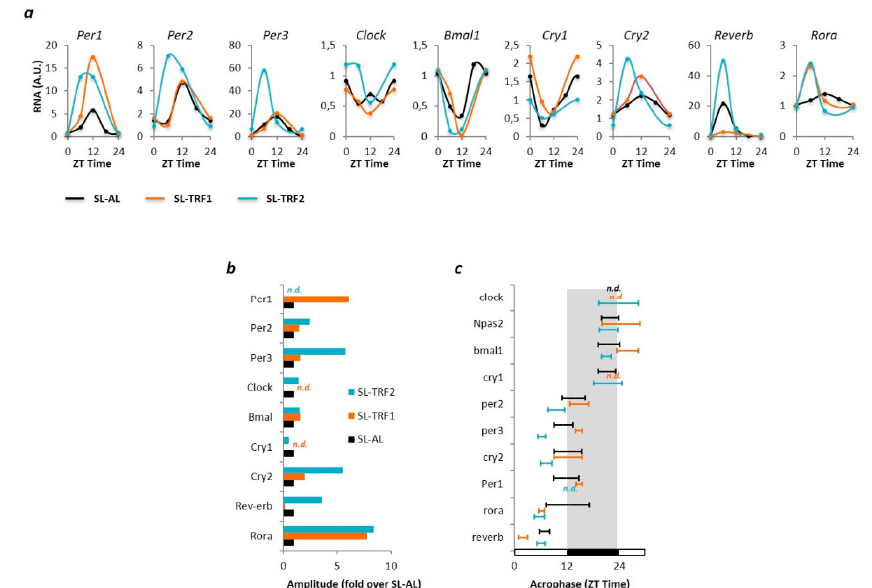
Figure 4. The chrono-nutritional interventions influence the expression of the hepatic clock genes in SL mice. ( a ) mRNA expression levels of the clock genes at different Zeitgeber Time (ZT) during a 24-h cycle in SL-AL mice (black) ( n ≥ 10), SL-TRF1 mice (orange) ( n ≥ 5) and SL-TRF2 (blue) ( n ≥ 5) after 4 weeks of intervention. Gene expression levels were normalized to b-Actin . Amplitude ( b ) and Acrophase ( c ) of the clock genes during the 24 h cycle in SL-AL (black), SL-TRF1 (orange) and SL-TRF2 (blue) mice after the 4-week intervention. Note that Acrophase is showed in reference to the light (white) or dark (black) period of the day. The acrophase and/or amplitude for some genes could not be detected due to either lack of rhythmicity or low N value.